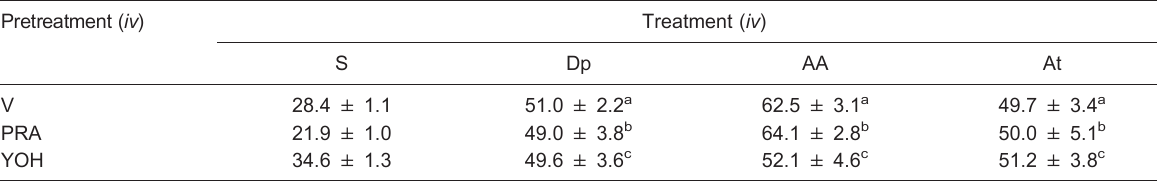
Table 1. Fractional gastric retention (%GR) of a liquid meal (saline) 10 min after administration to rats by gavage. Pretreatment ( iv )